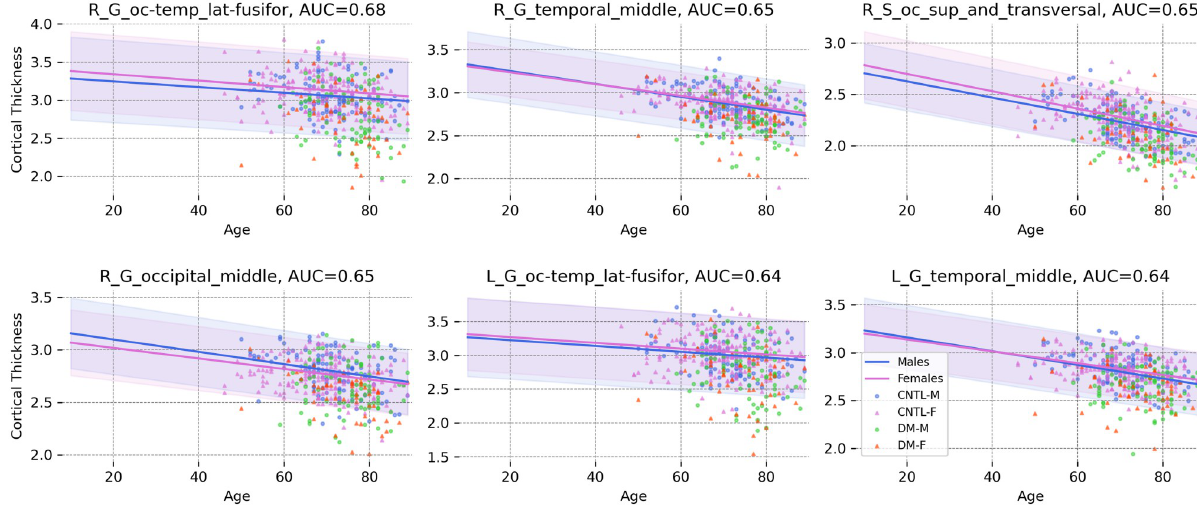
Fig 12. The norm and the 95% normative range for males and females in the 6 most distinctive cortical regions in dementia. Patients show lower cortical thickness than the norm of the population (Abbreviations: CNTL-F = healthy female, CNTL-M = healthy male, DM-F = female patient, DM-M = male